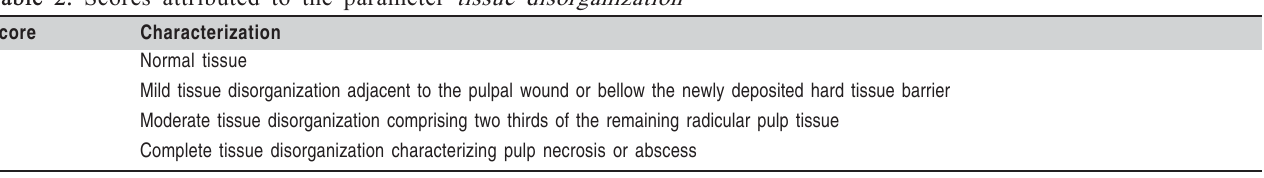
Table 2. Scores attributed to the parameter tissue